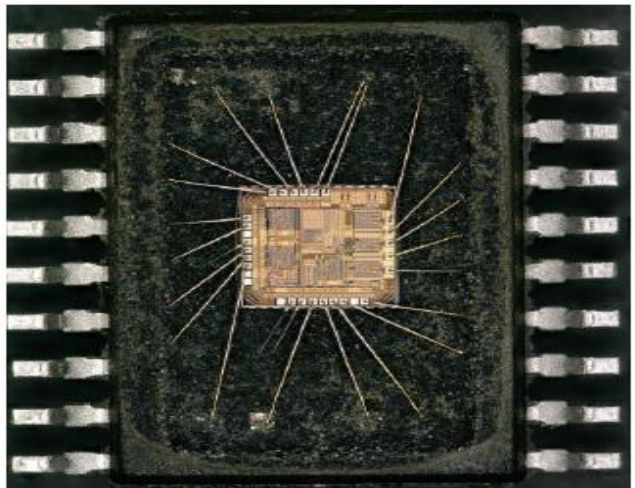
Figure 10. Integrated design diagram of SOC chip.